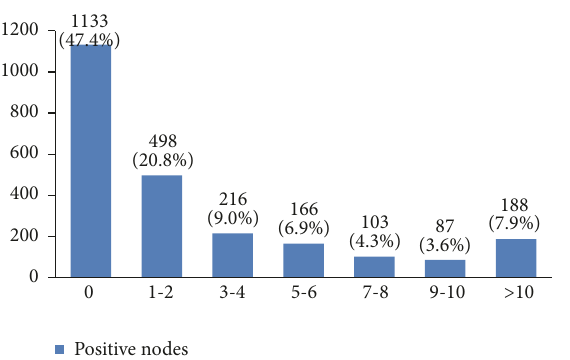
Figure 23: The axillary surgery type of the studied breast cancer cases.